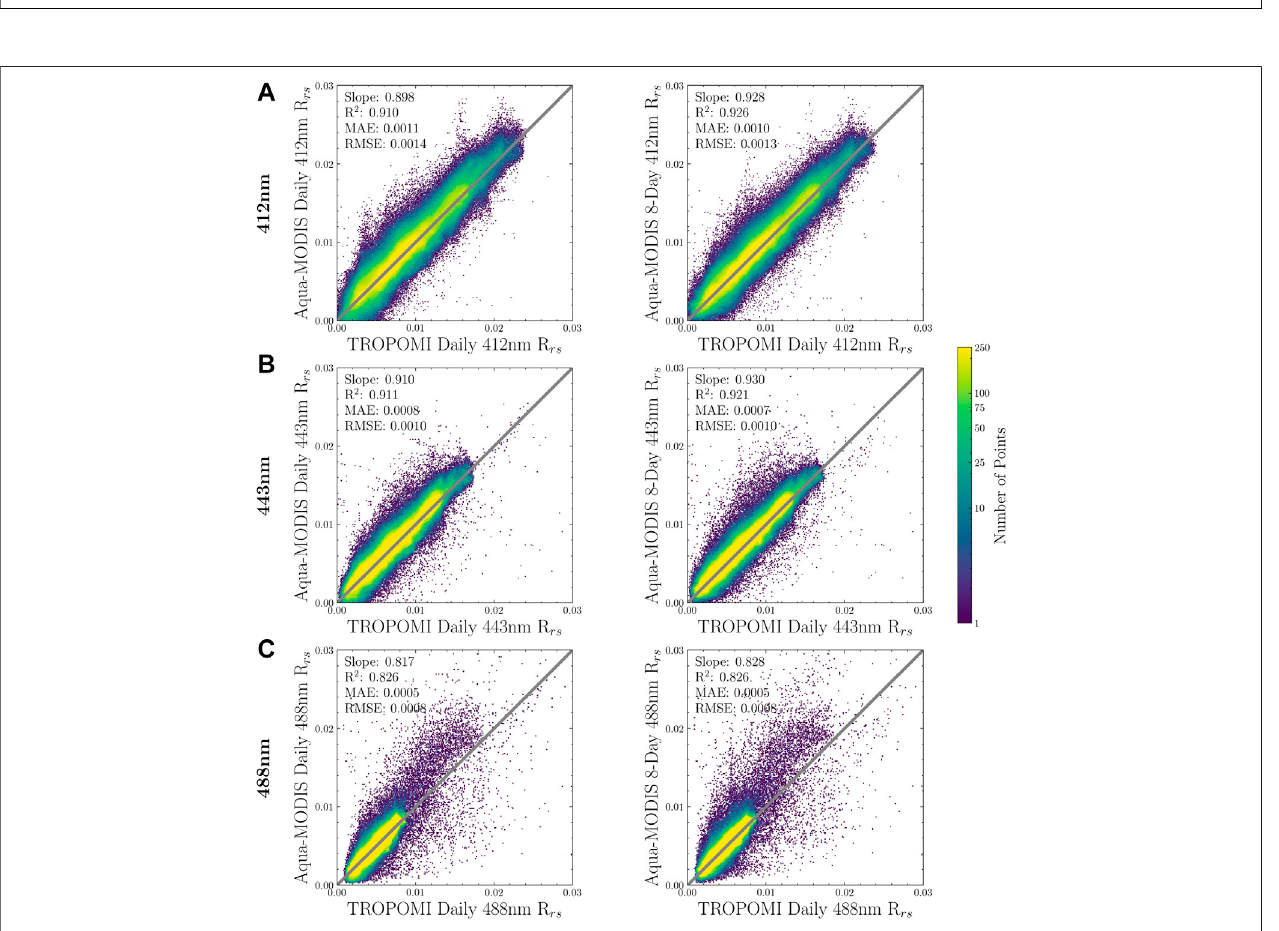
FIGURE 7 | Same as Figure 6 but for comparisons of R rs . (A) shows 412 nm R rs , (B) shows 443 nm R rs , and (C) shows 488 nm R rs .